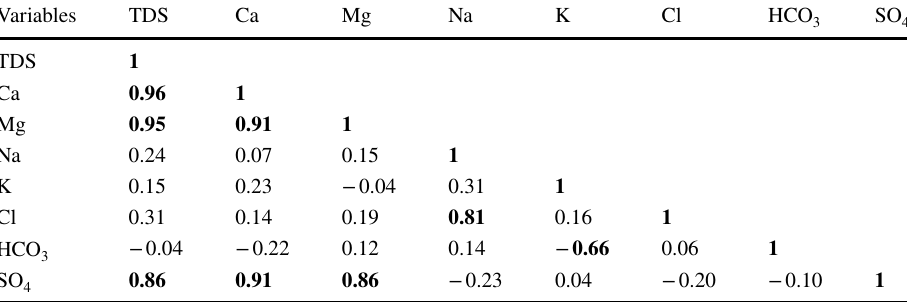
4 d Mg versus SO 4 and e Ca versus HCO 3 . C-T = Cenomanian-Turo-